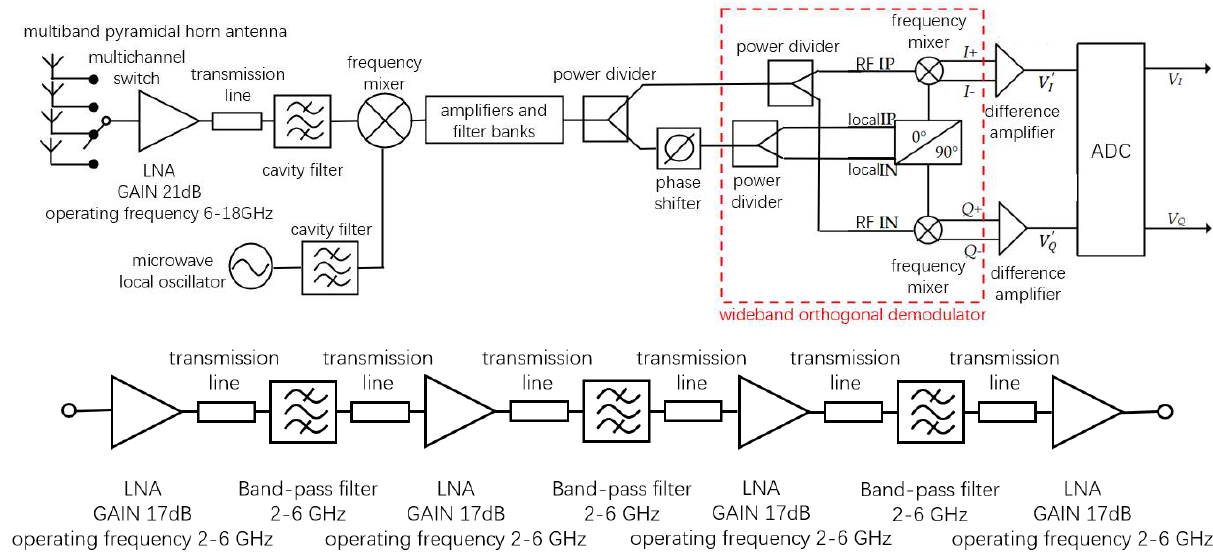
Figure 14. Design block diagram of novel interferometric microwave temperature radiometer. Upper panel: overall block diagram of the novel interferometric microwave radiometer; lower panel: partial block diagrams of amplifiers and filter banks.